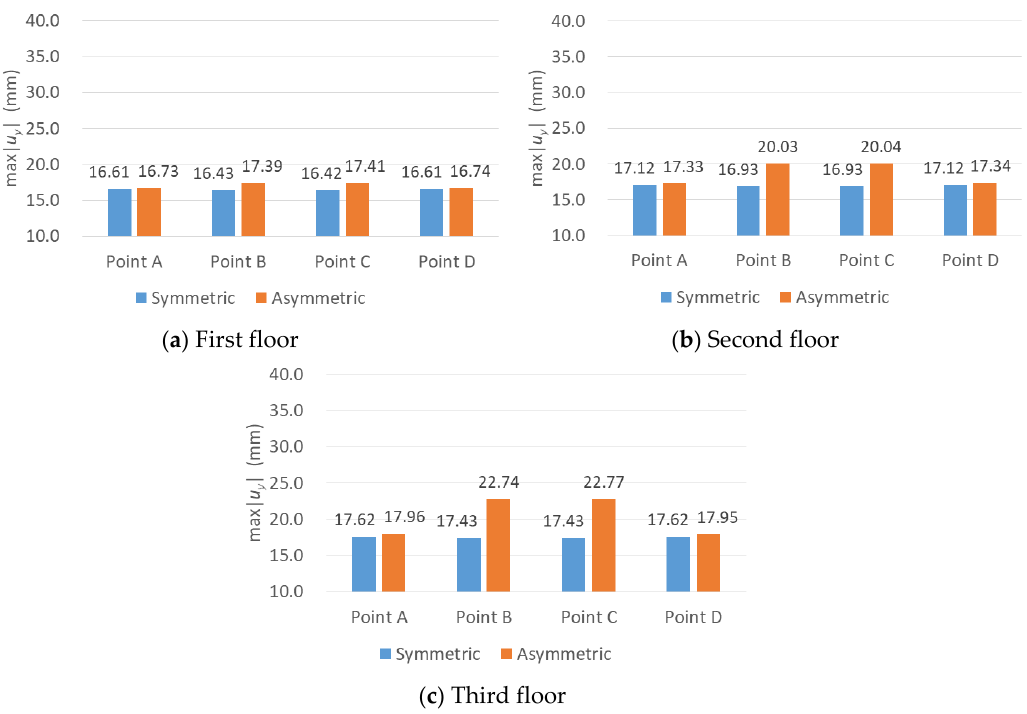
Figure 39. Absolute maximum displacement in the y direction of the asymmetric and the hypothetical symmetric structures due to the Northridge earthquake (Run 19).